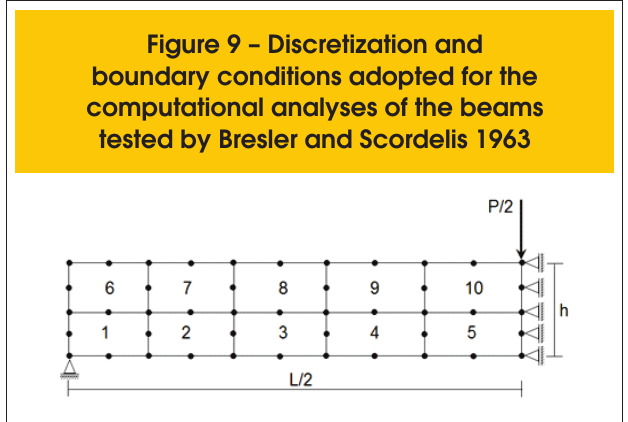
Figure 8 – Schematics of the beams tested by Bresler and Scordelis 1963